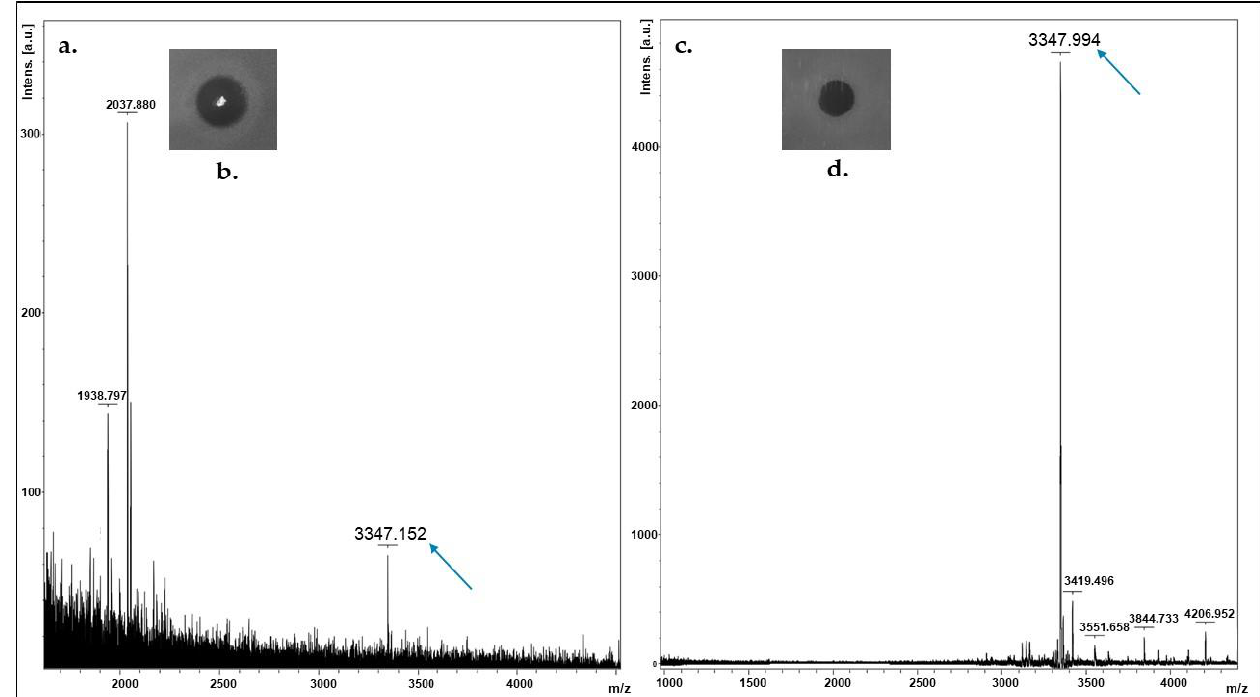
Figure 5. ( a ) Colony MALDI-TOF MS of L. salivarius P1ACE3; ( b ) direct antimicrobial activity of a single colony against P. damnosus 4797. ( c ) MALDI-TOF MS of the RP-FPLC active fraction from a purified supernatant of L. salivarius P1ACE3; ( d ) antimicrobial activity of the eluted fraction against P. damnosus CECT 4797.